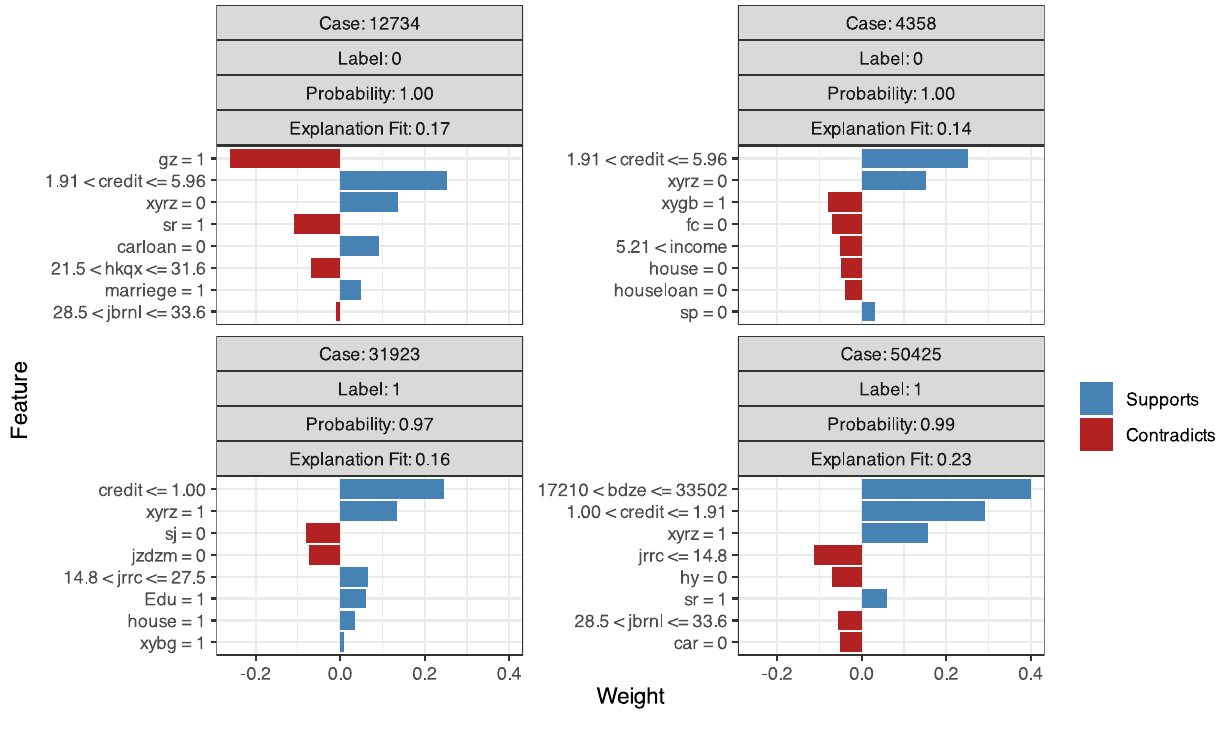
Figure 7. Variable weights of the XGBT model.